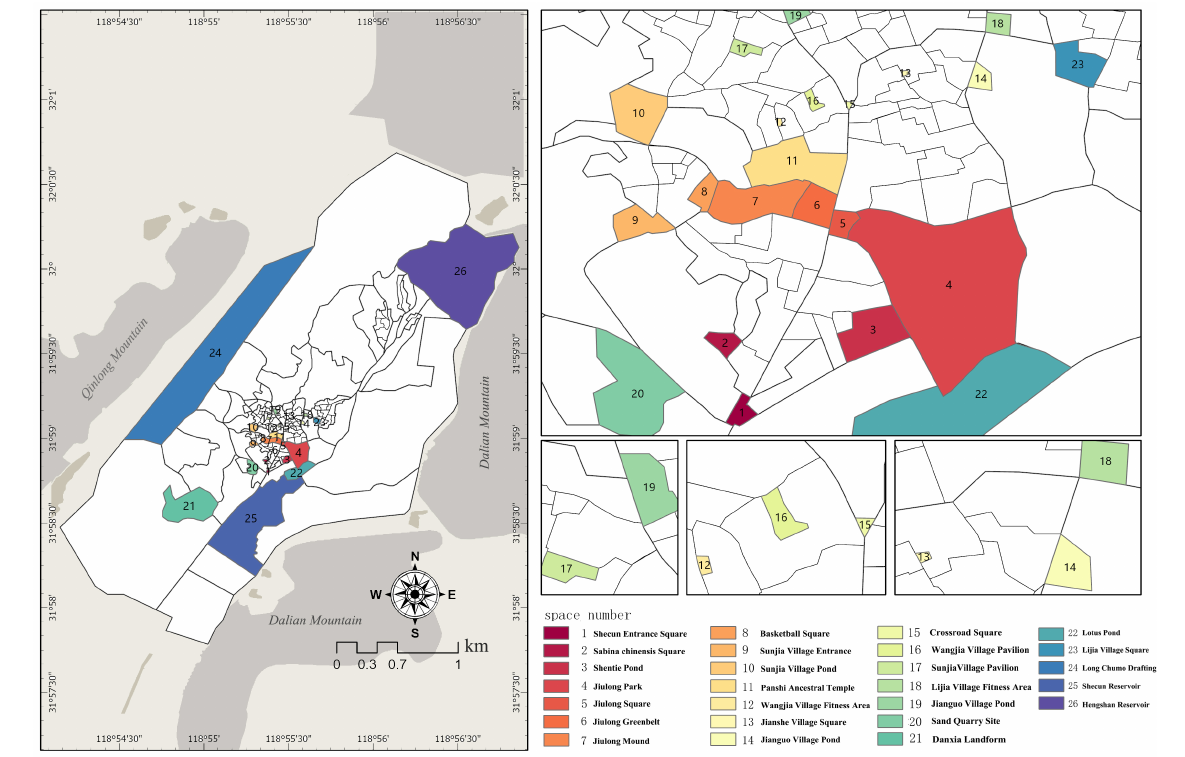
Figure 2. The layout of the Shecun Community and Public Space. Figure 2. . Table 1. Environmental Factors and